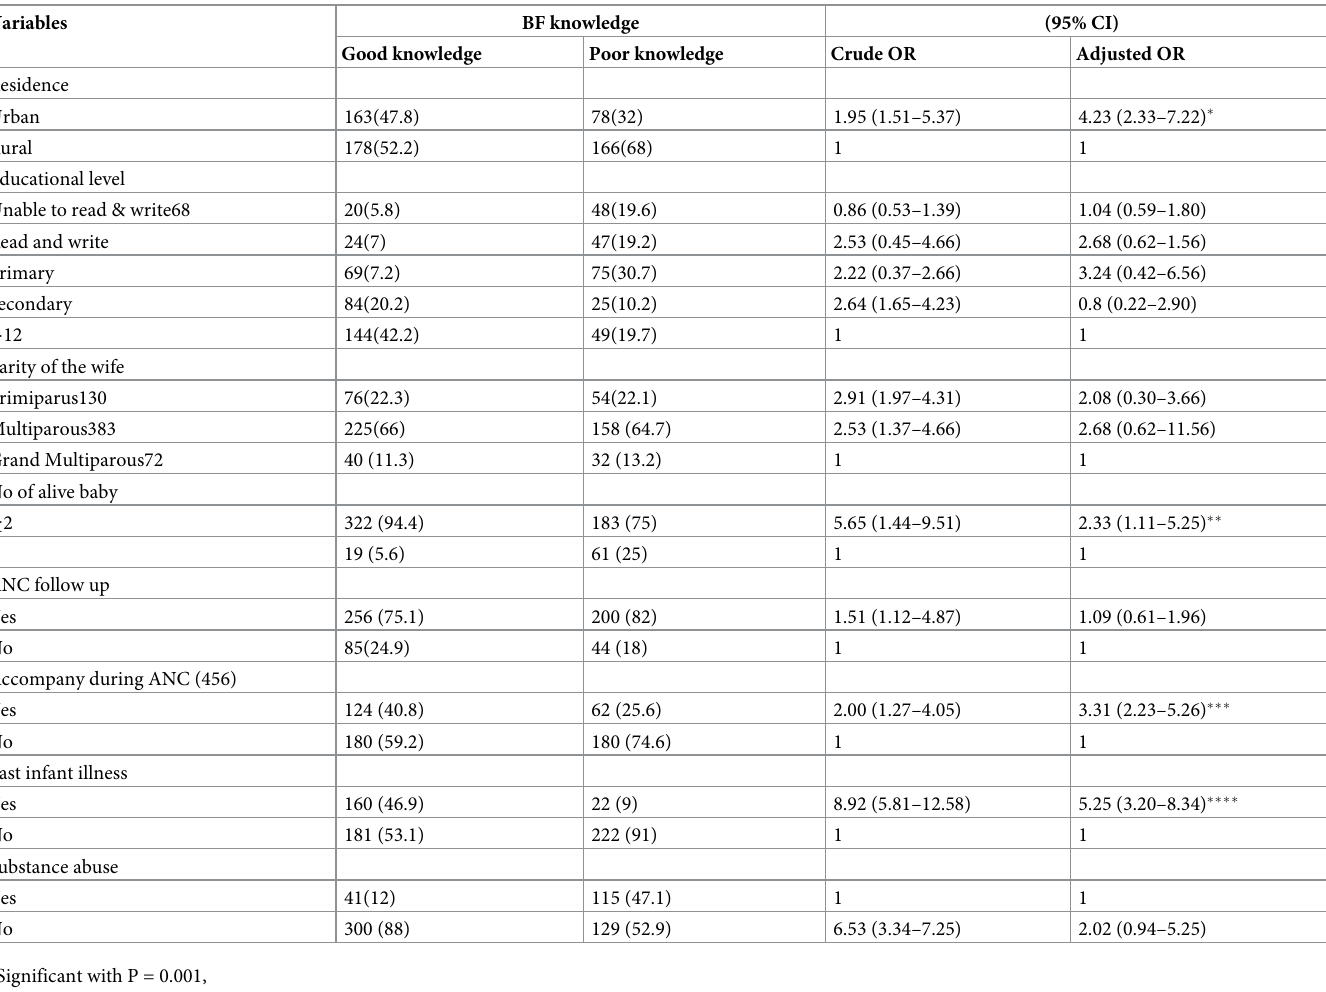
Table 3. Predictors of knowledge of fathers whose wife delivered in the last 1year towards breastfeeding in Gurage Zone, Southern Ethiopia.